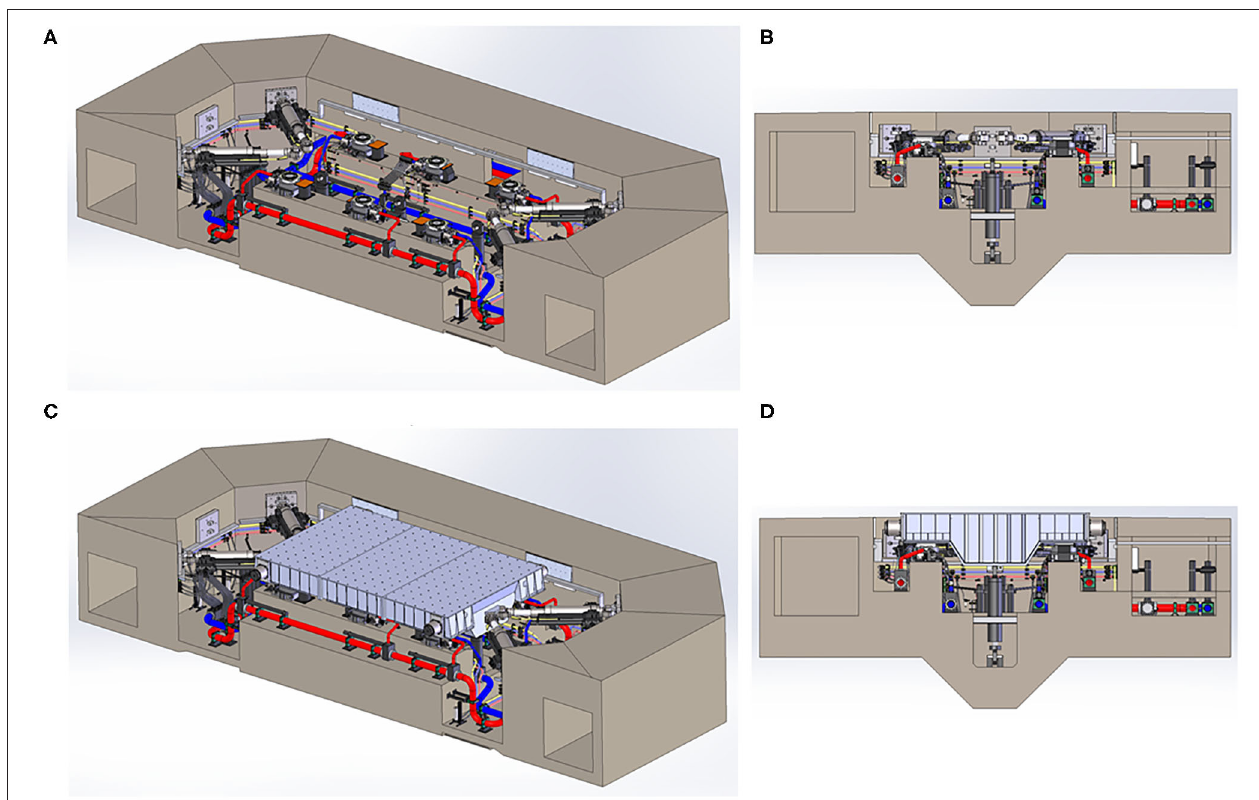
FIGURE 9 | Overall design configuration of the LHPOST6: (A) horizontal actuators in V-shape configuration, vertical actuators and pedestals to park the platen, (B) transverse view with horizontal actuators and hold-down struts, (C) horizontal actuators connected to shake table platen equipped with crash protection devices, and (D) transverse view with shake table platen equipped with crash protection devices.